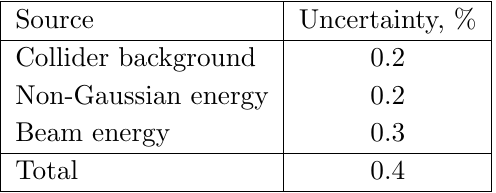
Table 8 . Accelerator-related uncertainties contributions in